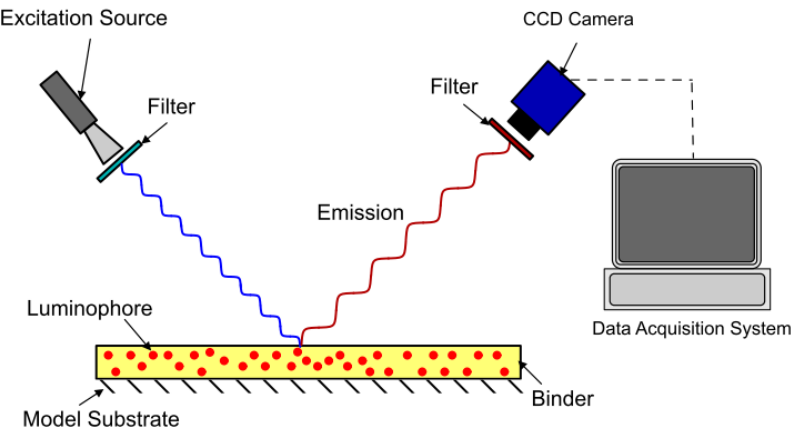
Figure 1. Polymer based PSP.